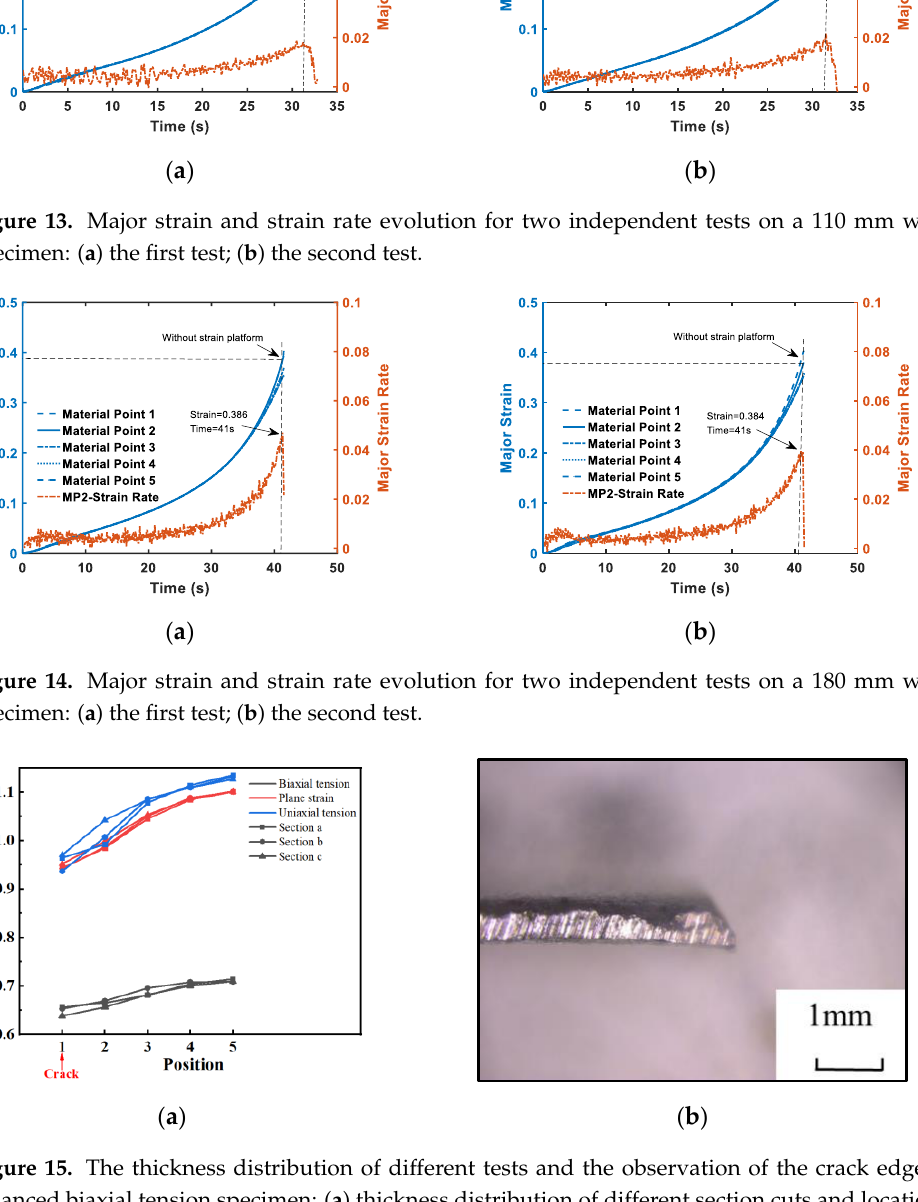
Table 4. Summary of the forming limit strain of high-strength steel sheet. Specimen Width (Unit: mm)